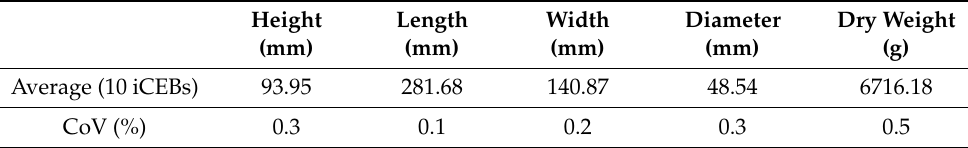
Figure 5. Test set-up for the characterization of the iCEBs produced: ( a ) geometrical stability; ( b ) compression test; and ( c ) three-point bending test. Table 3. Average dimensions and weight of the produced